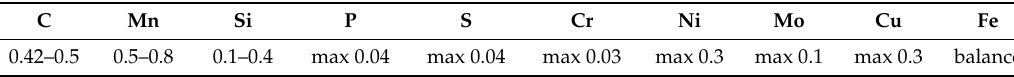
Table 3. Chemical composition of C45 grade steel (% by weight).